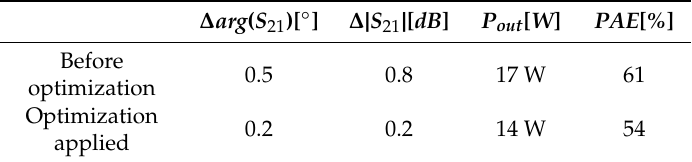
Figure 14. Simplified guidelines for proposed design methodology.